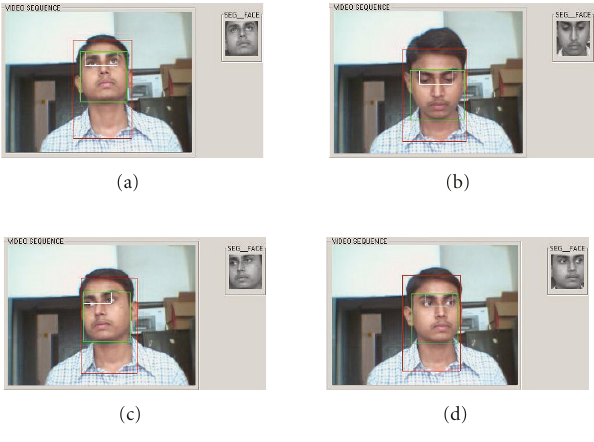
normalized to the k